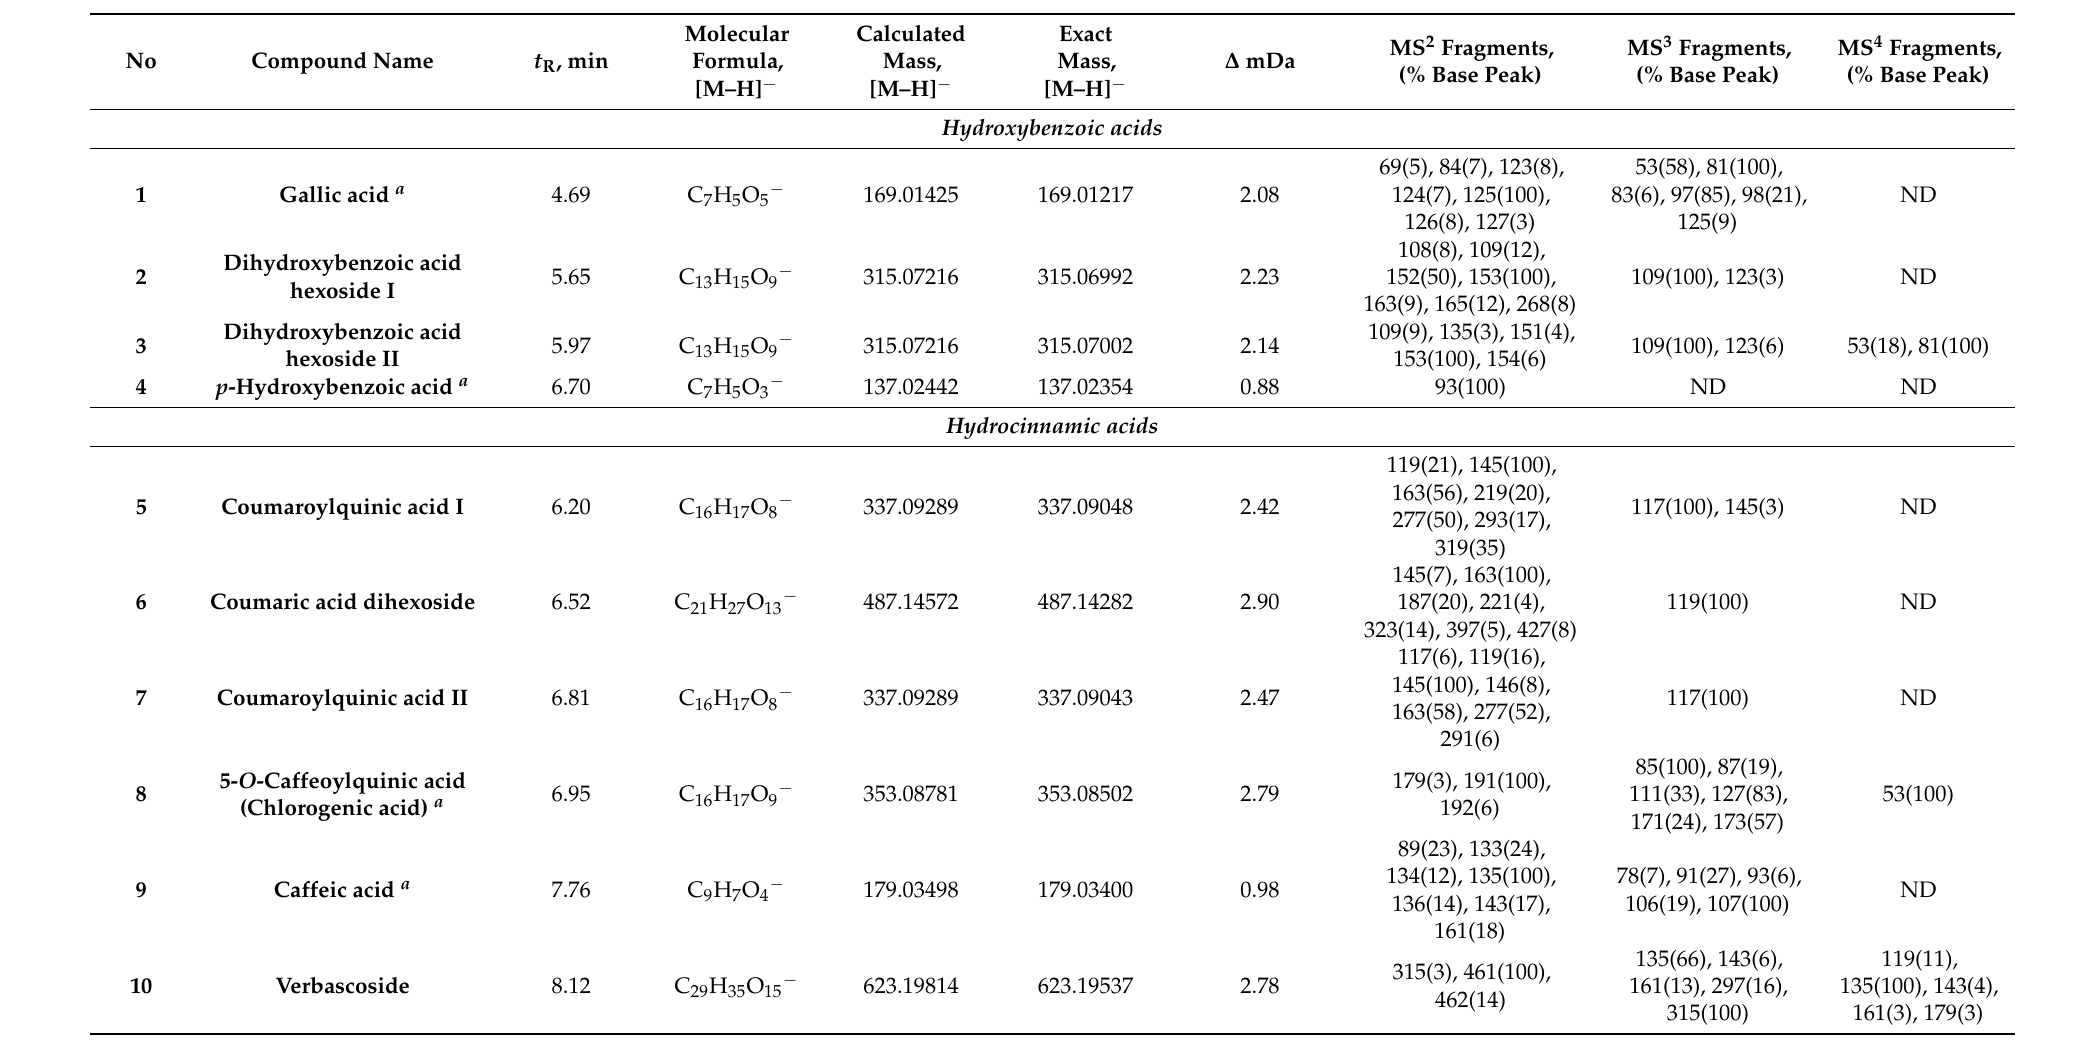
Table 1. UHPLC–MS 4 Orbitrap metabolic fingerprint (negative ionization mode) of R. holostea